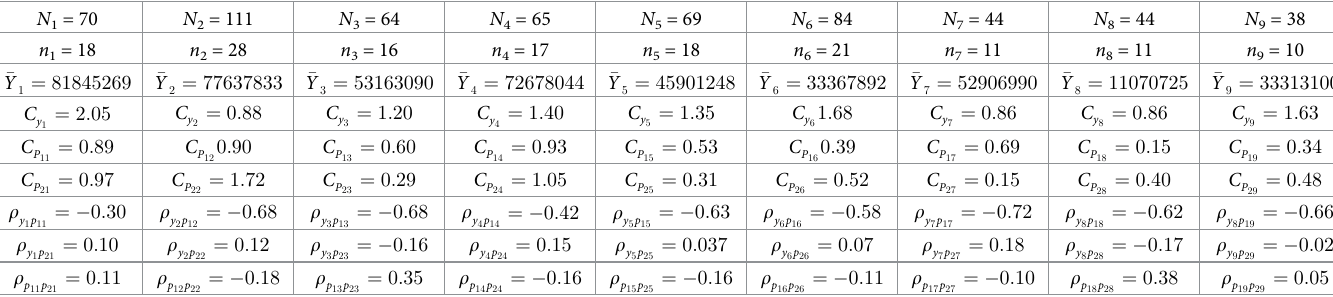
Table 8. Summary statistics of population 4.